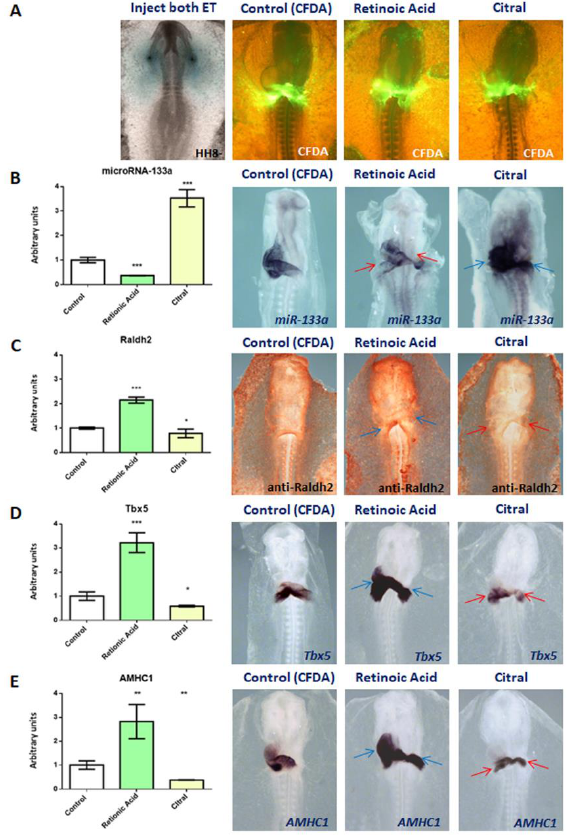
Figure 6. Whole-mount ISH for miR-133a, Tbx5 , AMHC1 and IMH for Raldh2. Embryos microinjected with CFDA (control), Retinoic acid (RA) or Citral, at the level of the posterior cardiac precursors into both primitive endocardial tubes, and visualisation of CFDA ( A ). The gain-of-function of RA leads to diminished miR-133a expression (red arrows) at the cardiac asa level ( B ), accompanied by increased protein levels of Raldh2 ( C ) and expanded expression of Tbx5 ( D ) and AMHC1 ( E ) in the heart tube and in the inflow tract (blue arrows). Note atrophic sino-atrial region with increased miR-133a expression (blue arrows) at cardiac asa level ( B ), and also (red arrows) diminished Raldh2 protein level ( C ), and decreased Tbx5 ( D ) and AMHC1 ( E ) expressions by RA synthesis inhibition. RT-qPCR of RNA from dissected cardiac asa (left side) in embryos microinjected either with CFDA, RA or Citral. The standard deviations are from three independent experiments. Student’s t -test: * p < 0.05, ** p < 0.01, *** p < 0.005 with respect to control (CFDA) embryos.